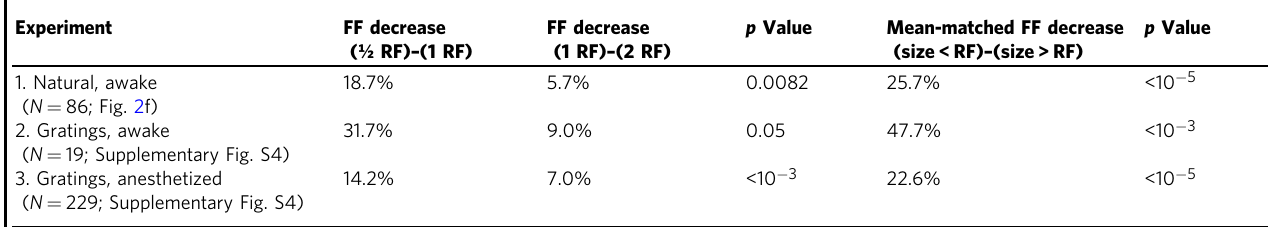
Table 1 Response variability decreases with stimulus